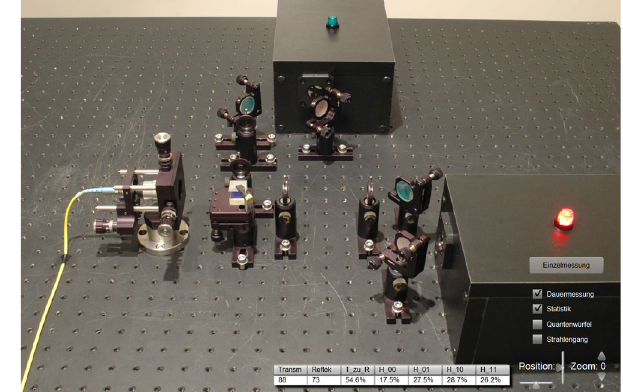
FIG. 3. Interactive screen experiment on the behavior of single photons at the beam splitter to make quantum random tangible [51].